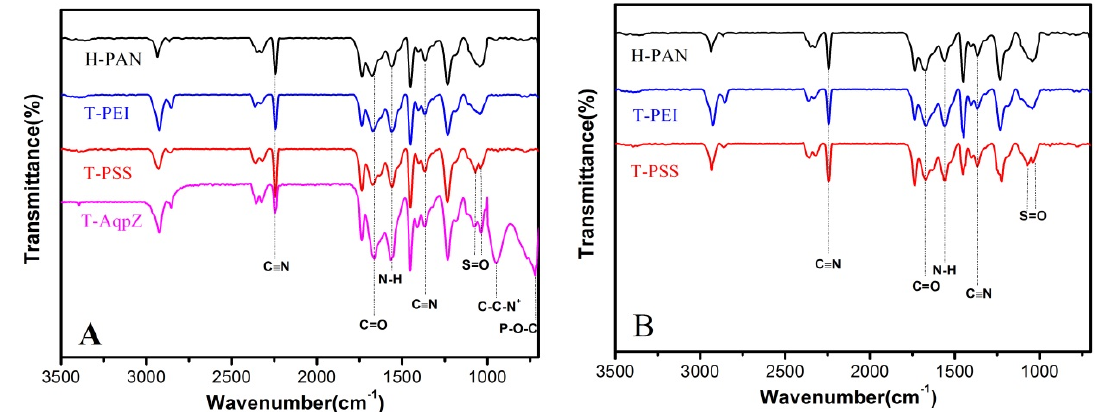
Figure 2. ATR-FTIR spectra of various membranes. ( A ) Top surfaces of membranes; ( B ) Bottom surfaces of membranes.